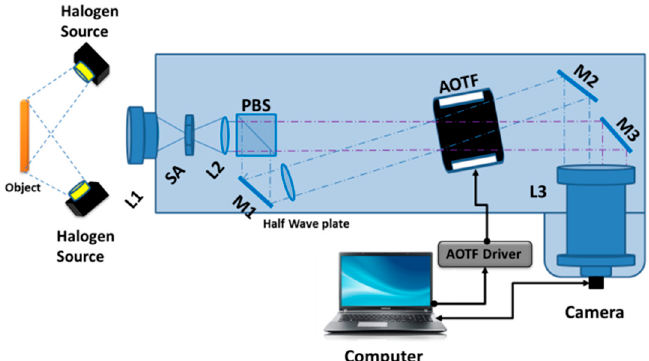
Figure 1. Schematic of the dual polarization acousto-optic tunable filter (AOTF)-based hyperspectral imaging (HSI) system. L1: zoom lens; SA: square aperture acting as field aperture; L2, L3: achromatic lenses; M1, M2, M3: flat mirrors; PBS: polarizing beam splitter. The optical imaging system is enclosed in an enclosure (shaded area) to ensure portability.